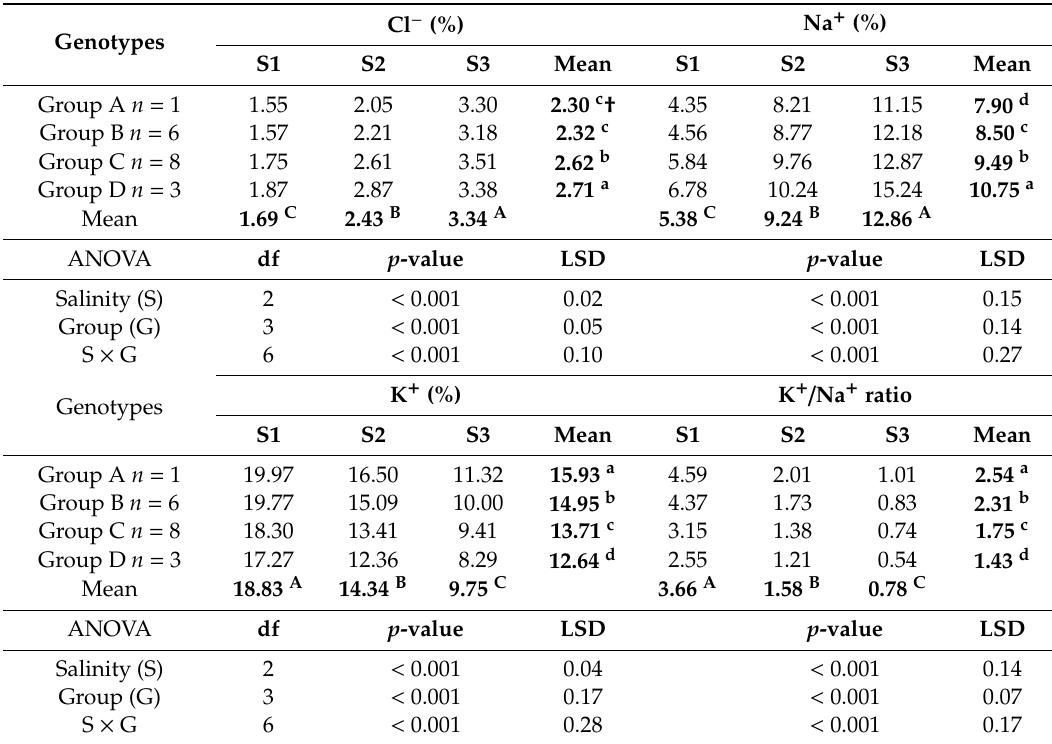
ratio of four genotype groups classified according to salinity tolerance under three salinity levels of